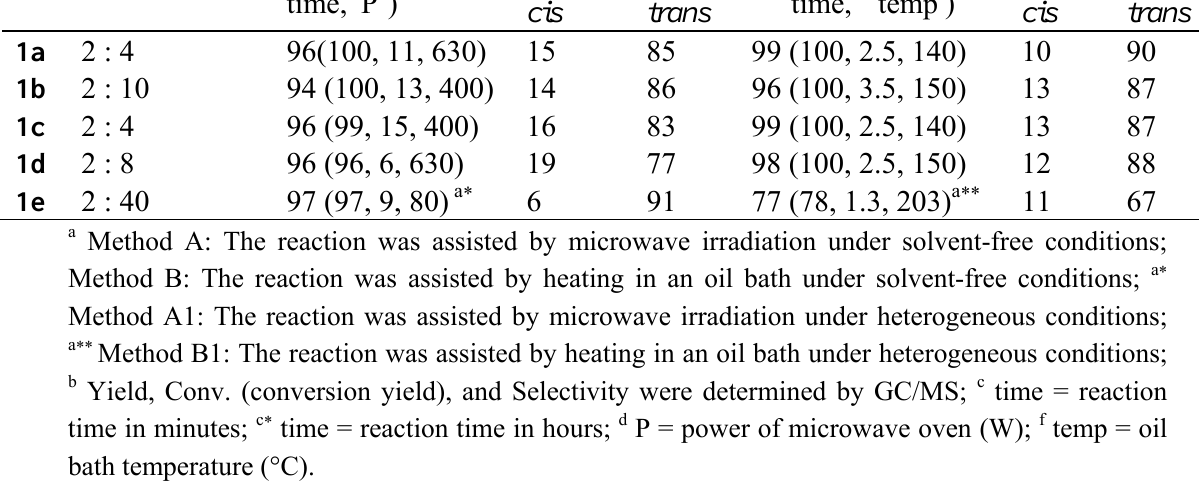
Table 1. Optimized results of allylbenzene isomerization by KF/Al